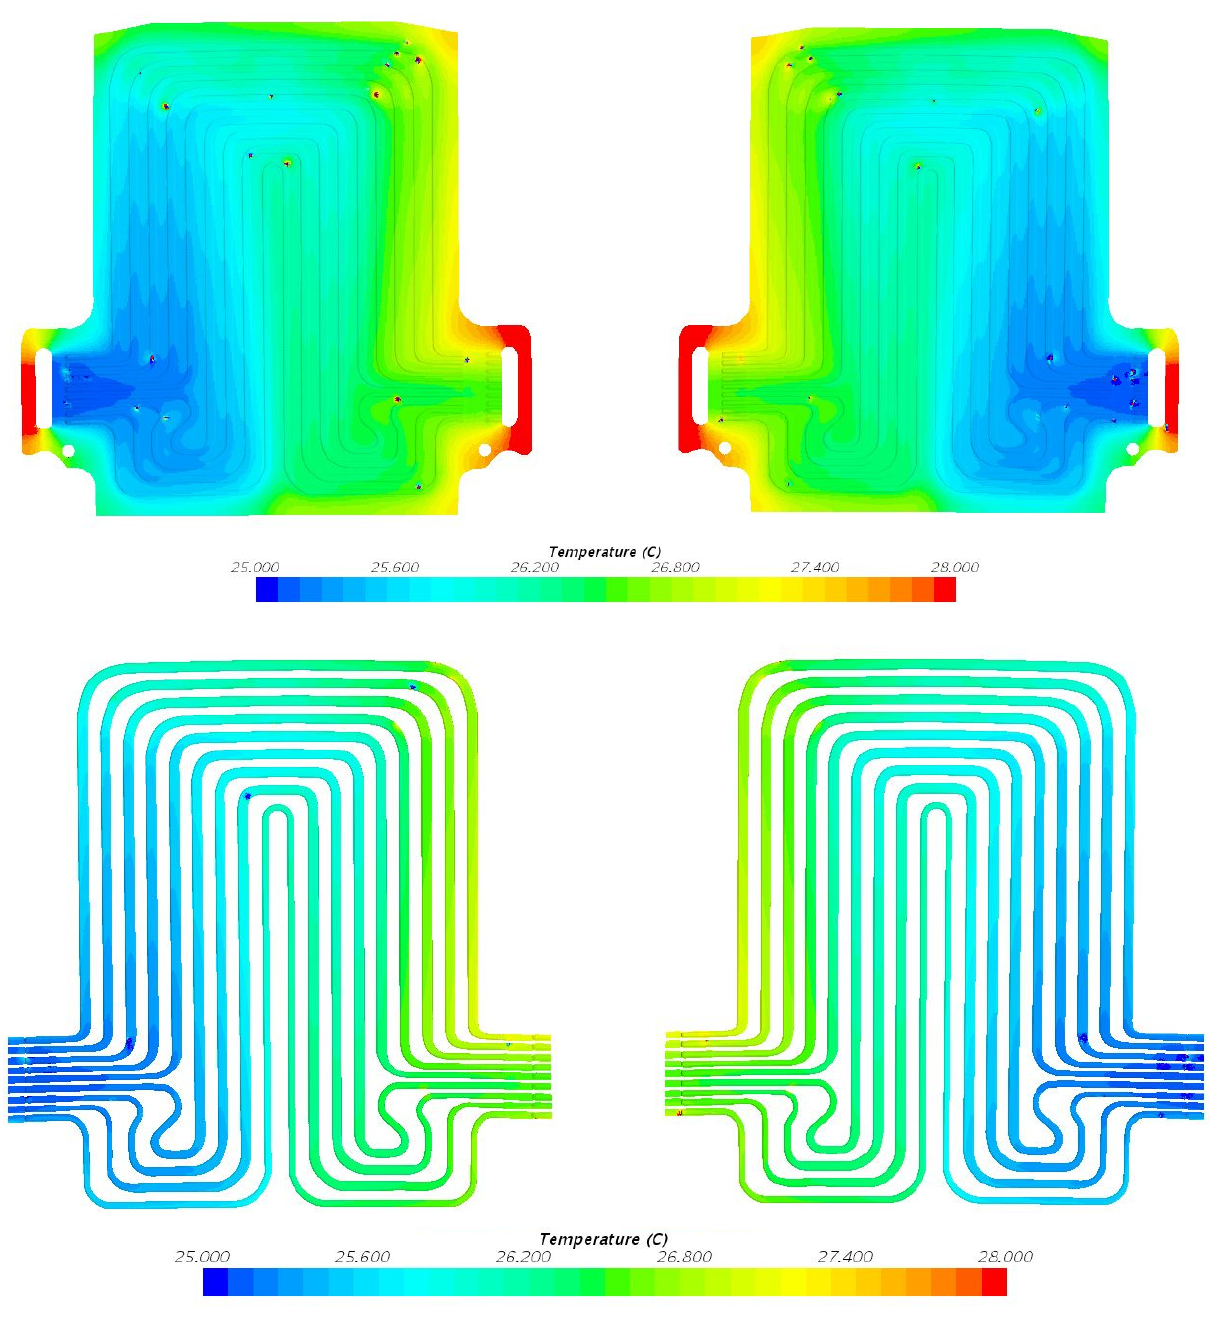
Figure 13. Temperature field at 40 A discharge current and 25 °C coolant inlet temperature, with heat flux at position 1 = 684.9 W/m 2 , position 2 = 733.2 W/m 2 , and position 3 = 194.8 W/m 2 .